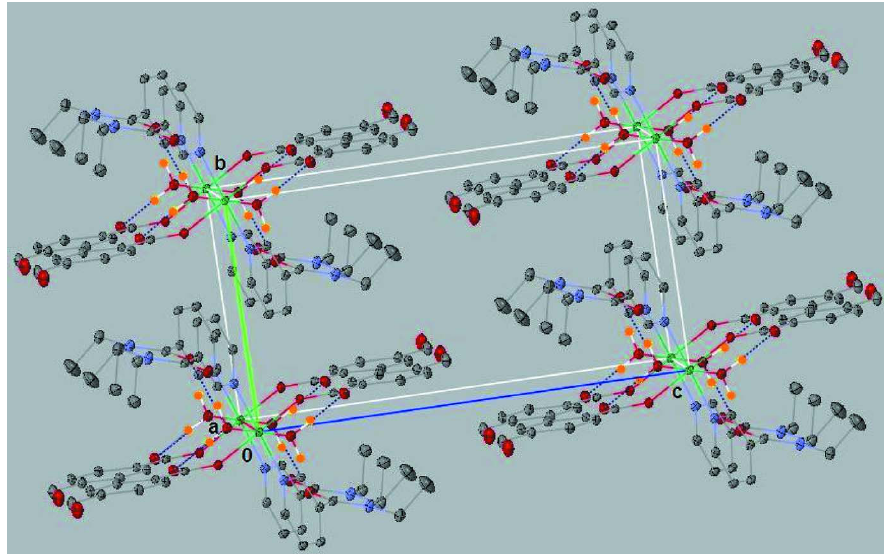
Figure 2 A partial packing diagram of the title compound viewed down the a axis, showing hydrogen bonds (dotted lines) linking the molecules into chains. H atoms not involved in hydrogen bonding have been